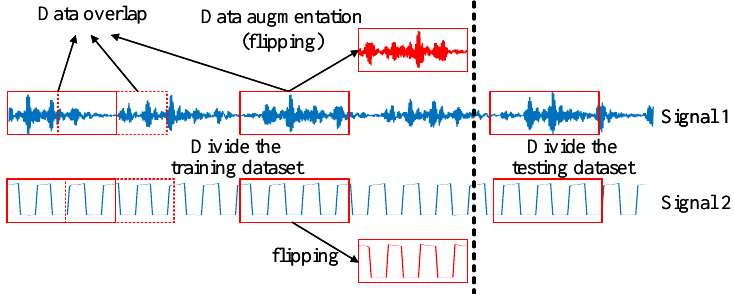
Figure 8. Method of bearing data augmentation for variable speed